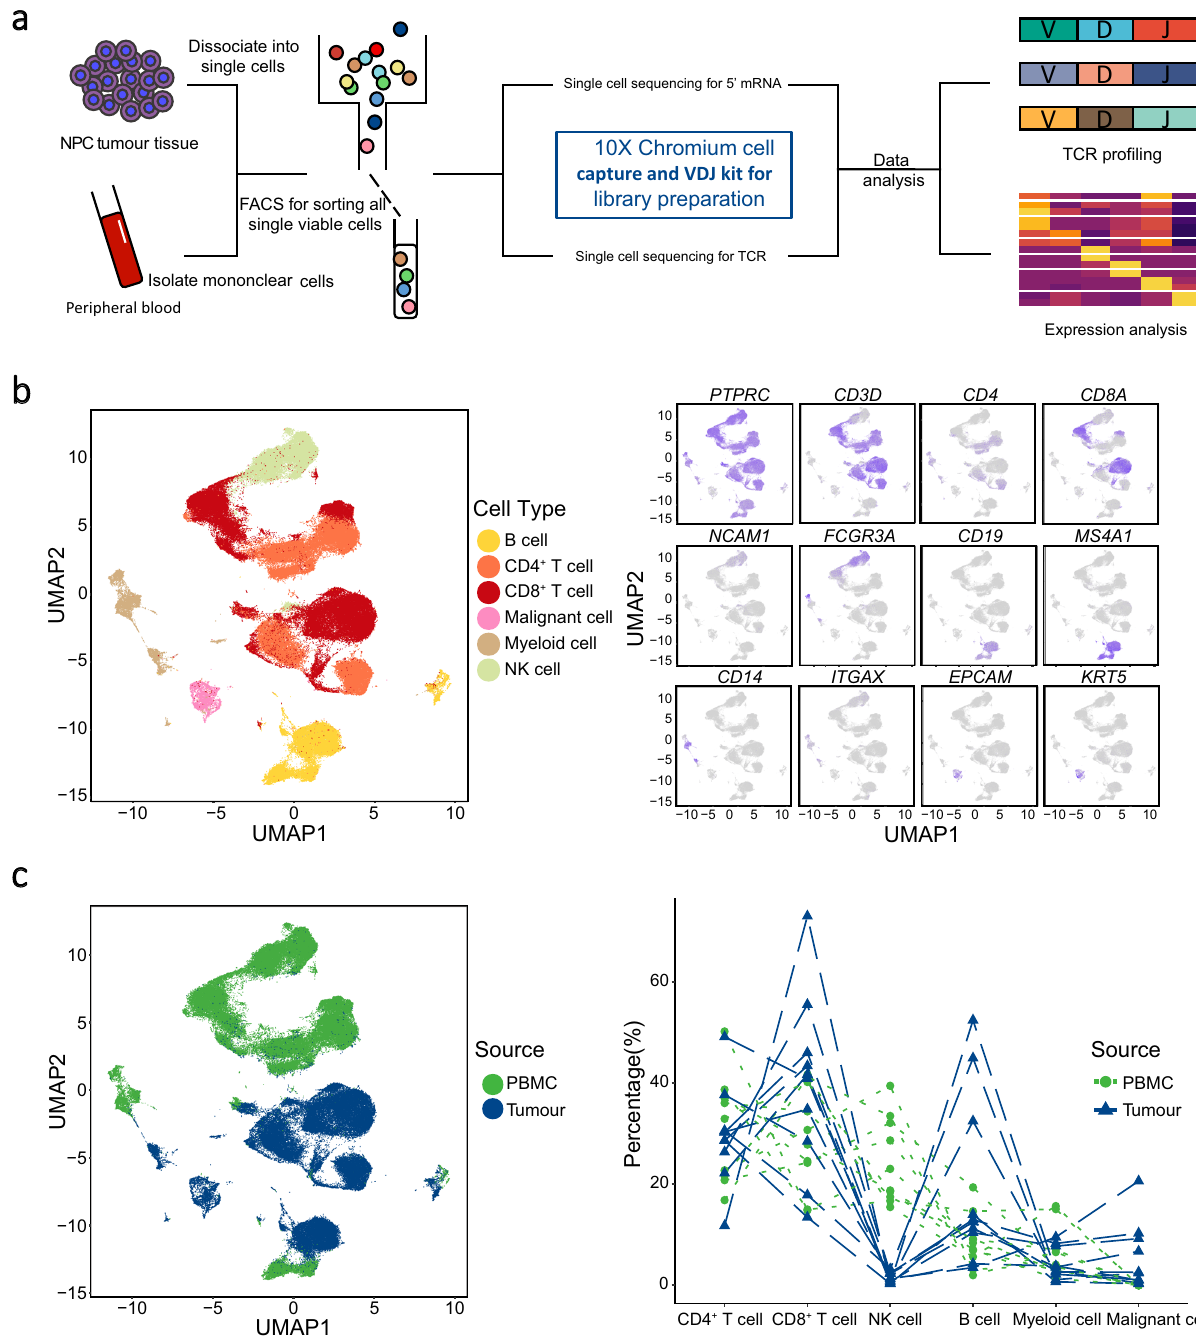
Fig. 1 The landscape pro fi ling of single cells in NPC tumours and matching PBMC. a An experimental scheme diagram highlights the overall study design. Single viable cells were collected using fl ow cytometry sorting (FACS) and subjected for cell barcoding. The cDNA libraries of 5 ’ -mRNA expression and TCR were constructed independently, followed by high throughput sequencing and downstream analyses. b UMAP plot of 176,447 single cells grouped into six major cell types (left panel) and the normalised expression of marker genes for each cell type (right panel). Each dot represents one single cell, coloured according to cell type (left panel), and the depth of colour from grey to blue represents low to high expression (right panel). c UMAP plot of the above single cells coloured according to their origins from peripheral blood or tumour (left panel), and the fraction of cell types originating from each patient (right panel). Each dot represents one single cell, coloured according to sample